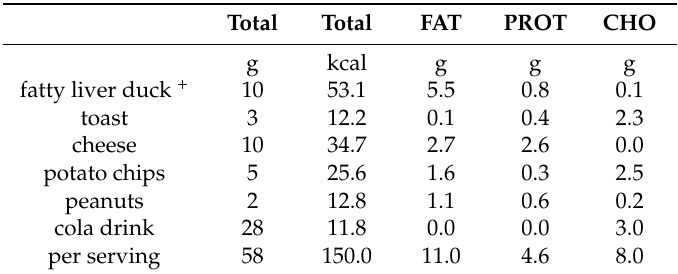
Table 1. Probe meal: content per serving *.